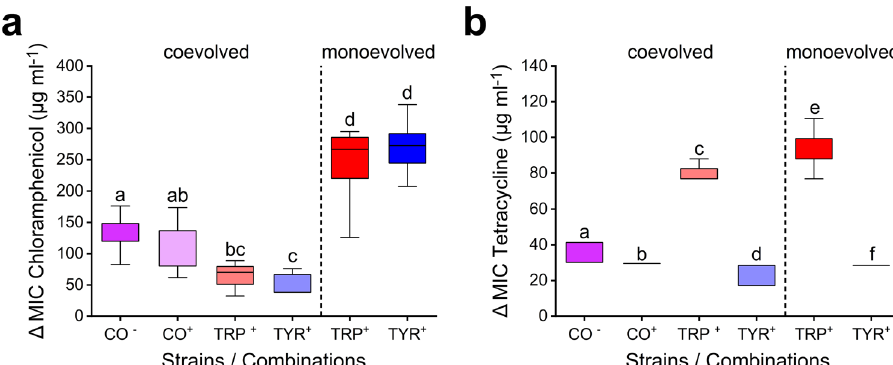
Fig. 3 Strain-level differences cause increased susceptibility of cooperative consortia to environmental stress. Minimum inhibitory concentration (MIC) values of ancestral (Supplementary Fig. 3) and derived strains and consortia that had evolved in the presence of a chloramphenicol and b tetracycline were assessed. Δ MIC is the difference between both values, thus indicating the increase in resistance over the course of the evolution experiment. Cocultures (CO, purple boxes) and monocultures of the tryptophan (TRP, red boxes) and tyrosine auxotrophs (TYR, blue boxes) of coevolved and monoevolved populations were analysed with ( + ) or without ( − ) amino acid supplementation (100 µ M each). Box plots show median values (horizontal line in boxes) and the upper and lower quartiles (i.e. 25 – 75% of data, boxes). Whiskers indicate the 1.5x interquartile range. Different letters above boxes indicate signi fi cant differences between groups (two-sided Mann – Whitney U -test followed by Benjamini – Hochberg correction: P < 0.05, n = 8). For exact P -values, see Supplementary Table 4. Source data are provided as a Source Data fi le.